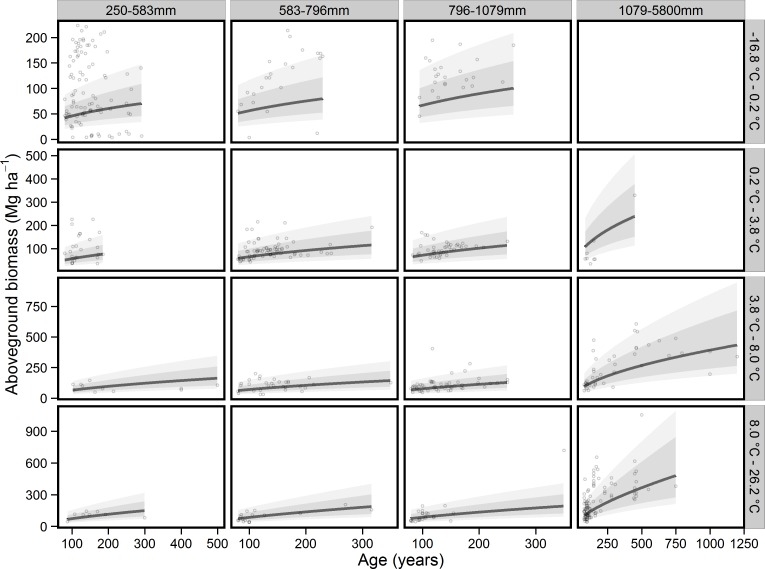
The relationship between forest age and aboveground biomass for differing climate spaces.Panels represent binned mean annual temperature (rows) and total annual precipitation (columns). Points represent individual sites and solid lines predictions from model-averaged coefficients of models with a ΔAICc ≤ 7. The dark band around predictions represents the 95% confidence interval of the coefficient, with the lighter band representing the 95% confidence interval when uncertainty in random effects is taken into account. Bins represent quartiles for precipitation and temperature so that each bin contains a similar number of data points. Please note that the y axes are not the same for all panels.